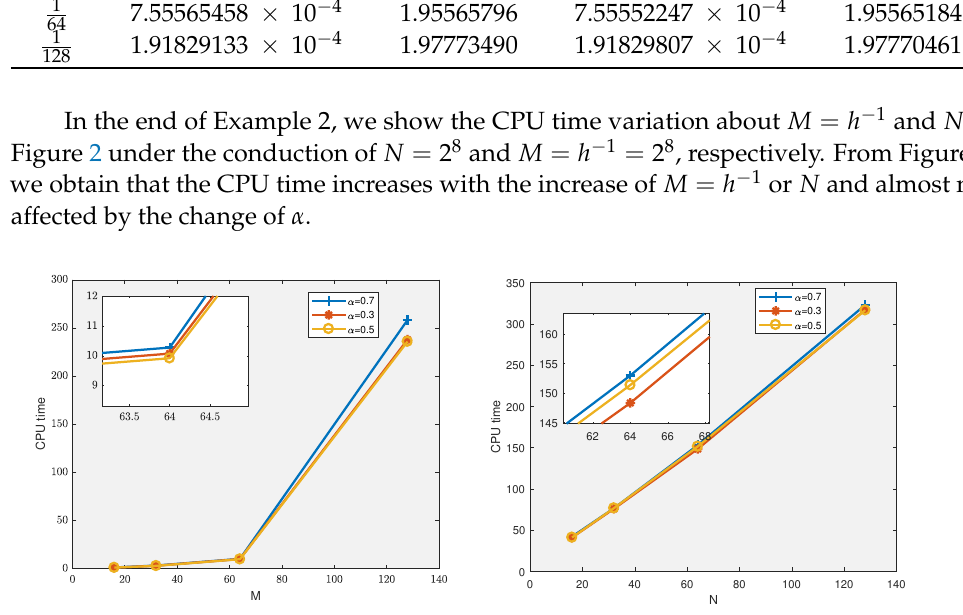
Figure 2. The CPU time with respect to M = h − 1 ( left ) and The CPU time with respect to N ( right